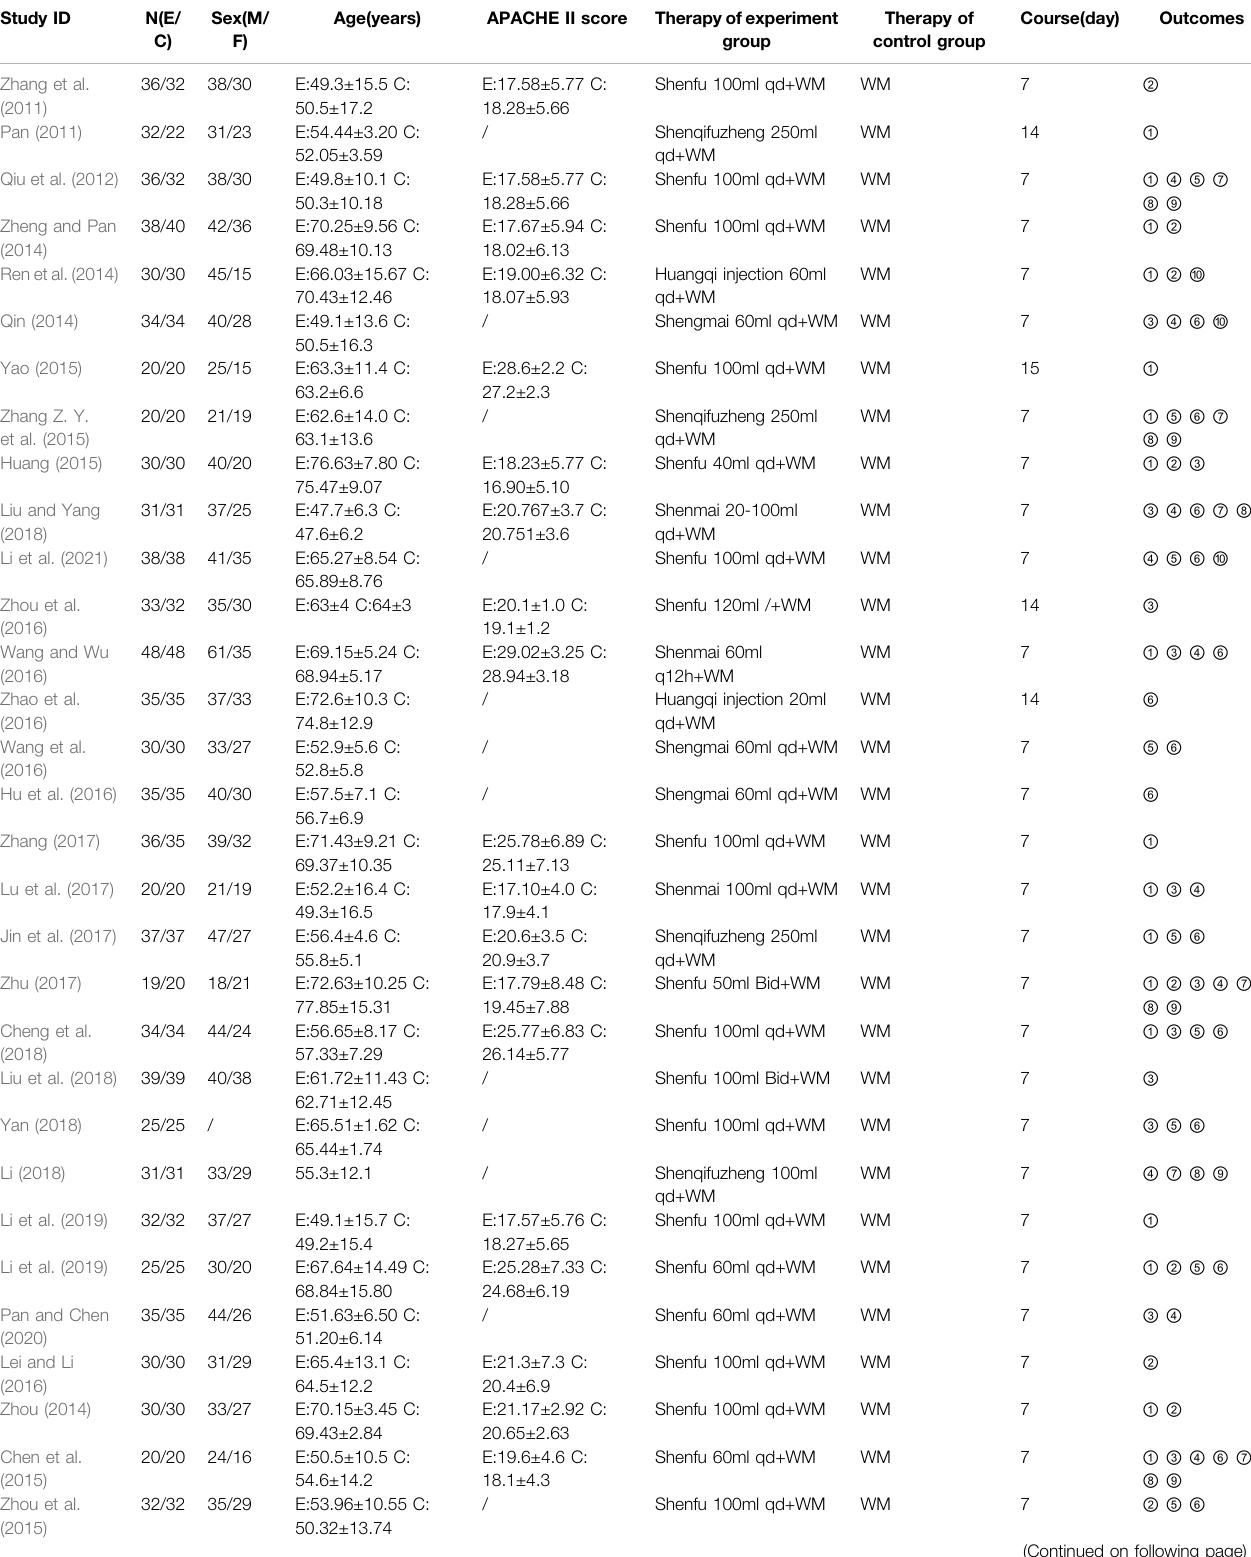
TABLE 1 | Characteristics of the studies included in this